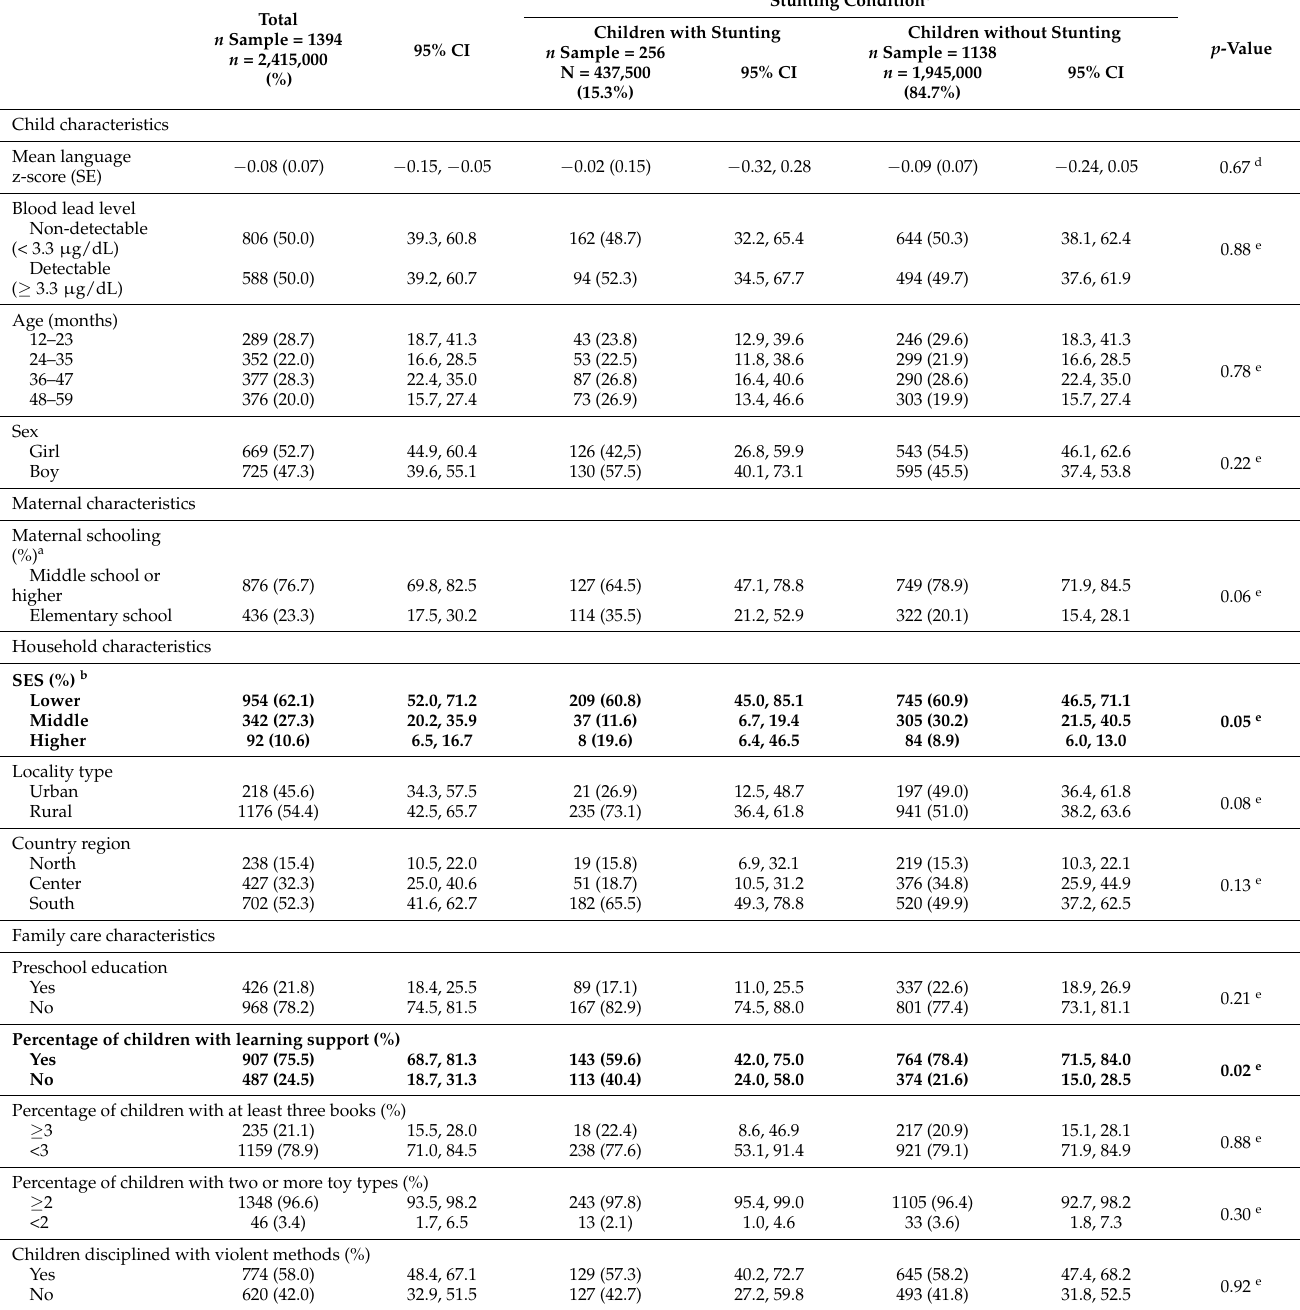
Table 1. Child, maternal, household, and family care characteristics by stunting